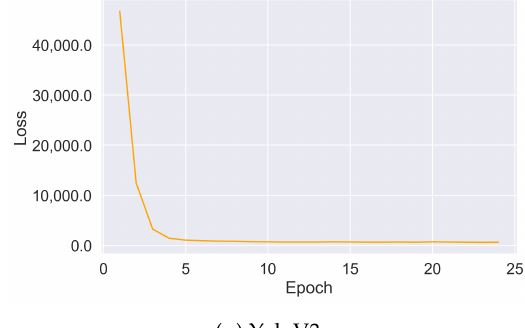
Figure 4. Loss curves for training (blue) and validation (orange) for each object detection method. For YoloV3, NAS-FPN, and FoveaBox, we only show the validation curves since the log for these two methods did not return the training